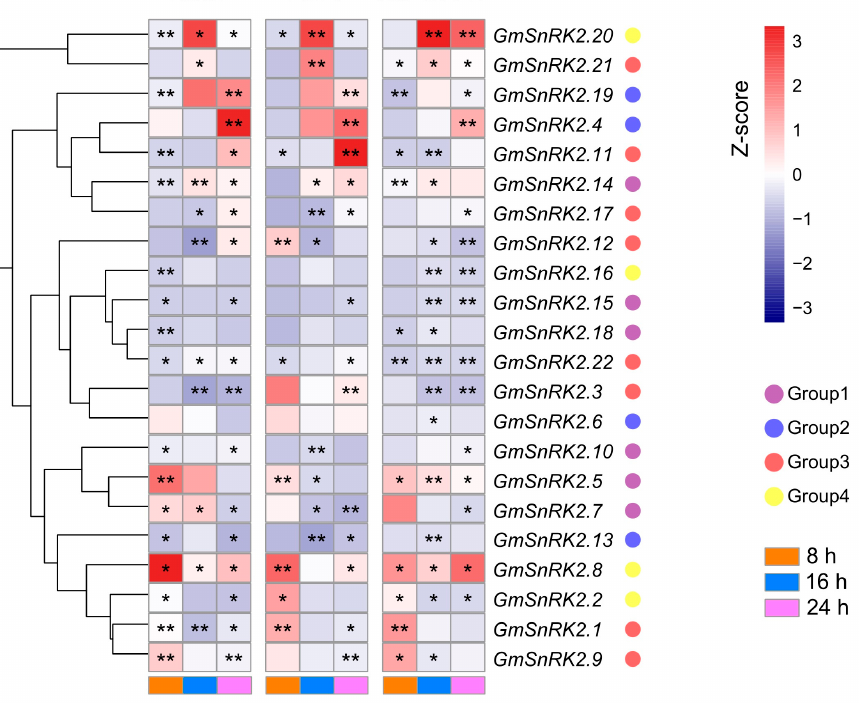
Figure 4. Expression analysis of the GmSnRK2s under salt, abscisic acid (ABA) and strigolactones (SLs) treatments. Heatmaps showed the expression patterns in quantitative real time polymerase chain reaction (qRT-PCR) experiments for the 22 GmSnRK2 genes under the treatments of NaCl, ABA and rac -GR24. The transcript levels of the GmSnRK2s were normalized against GmSKIP transcript levels using 2 −ΔΔ C t . The clustered heatmaps was generated in R using the pheatmap function package. The color scale indicating Z-score value, the Group names of GmSnRK2s and time points are shown at the right. Statistically significant differences (Student’s t -test) are indicated as follows: * p < 0.05, ** p < 0.01.